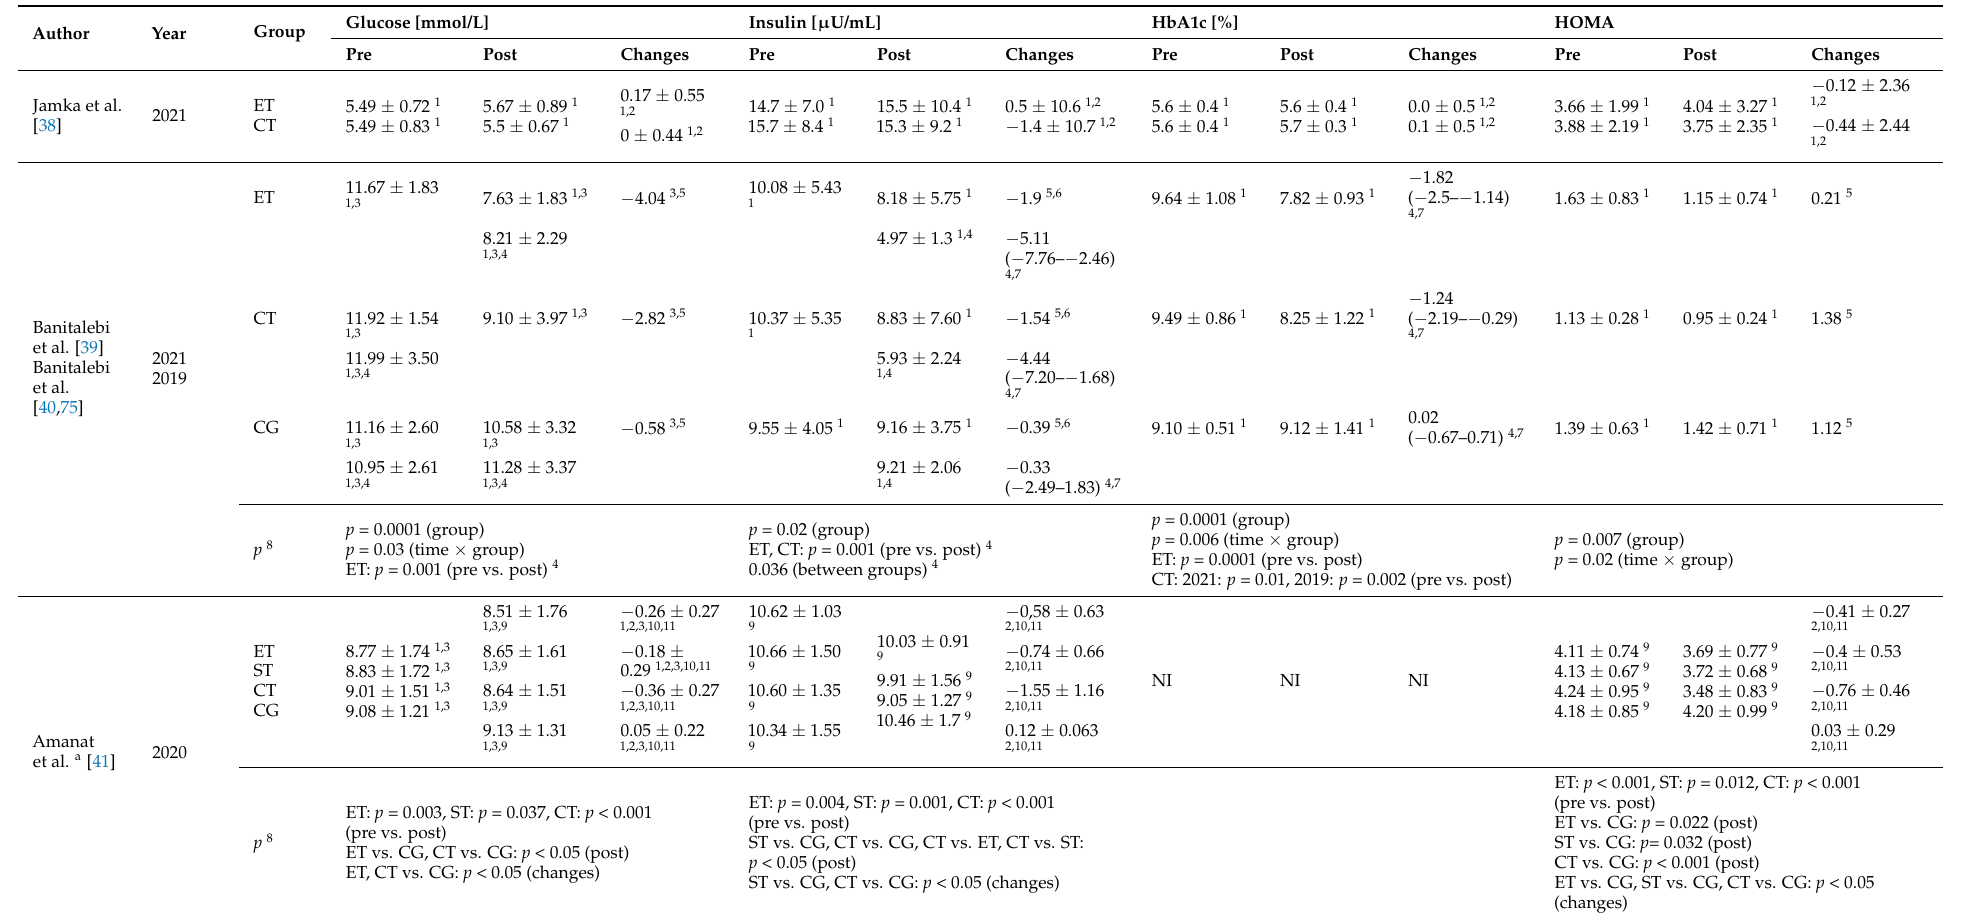
Table 3. Glucose and insulin metabolism parameters in studied